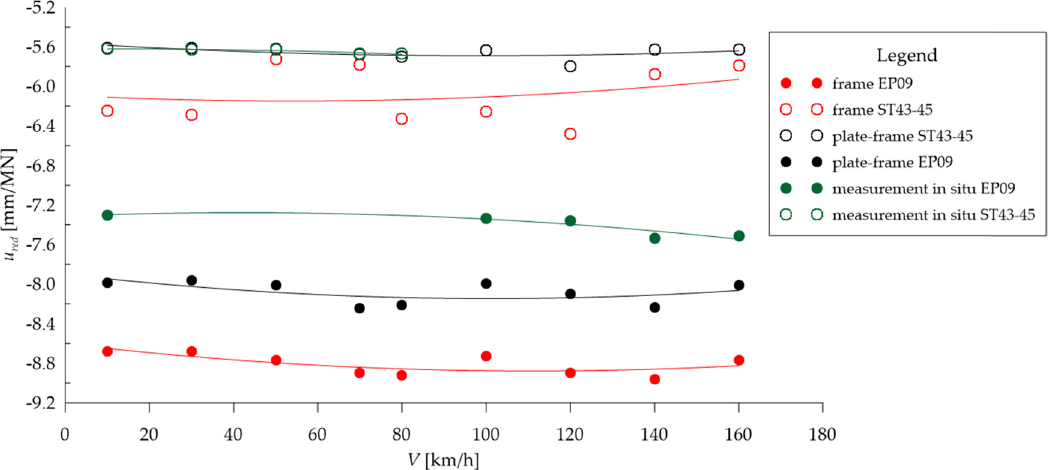
Figure 8: Graph of the values of reduced vertical displacements u red depending on the locomotive speed v , continuous lines represent trend based on measurements or calculated